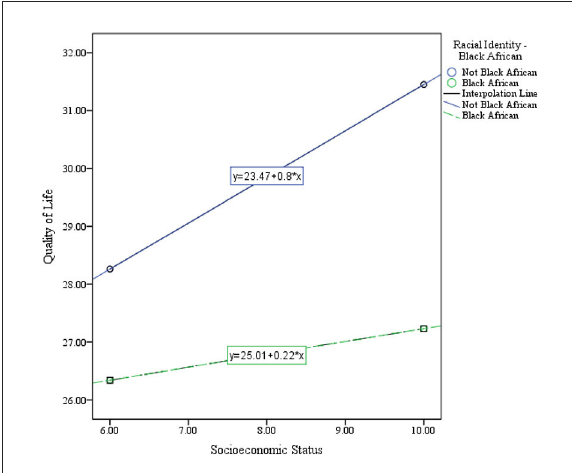
FIGURE4 Black African racial identity as a moderator of the association between SES and